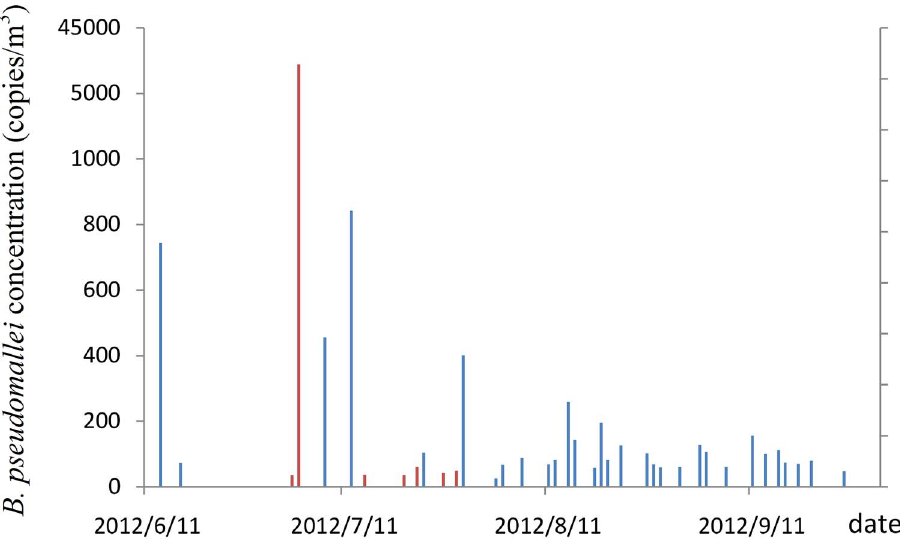
Figure 4. The ambient B.pseudomallei concentration profile from June to September 2012.